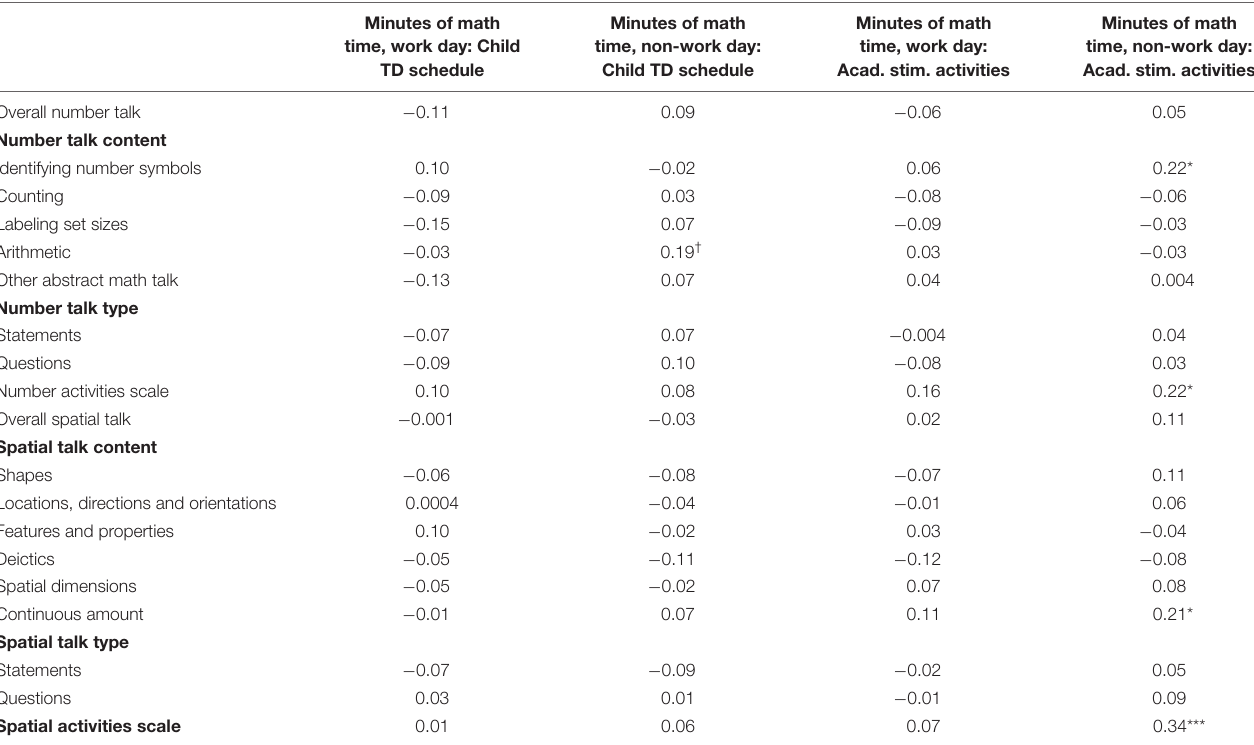
TABLE 9 | Associations among number and spatial talk content from the semi-structured observations, home number and spatial activities scale, and time in math activities reported on work and non-work days from the time diary interview. Minutes of math time, work day: Child TD